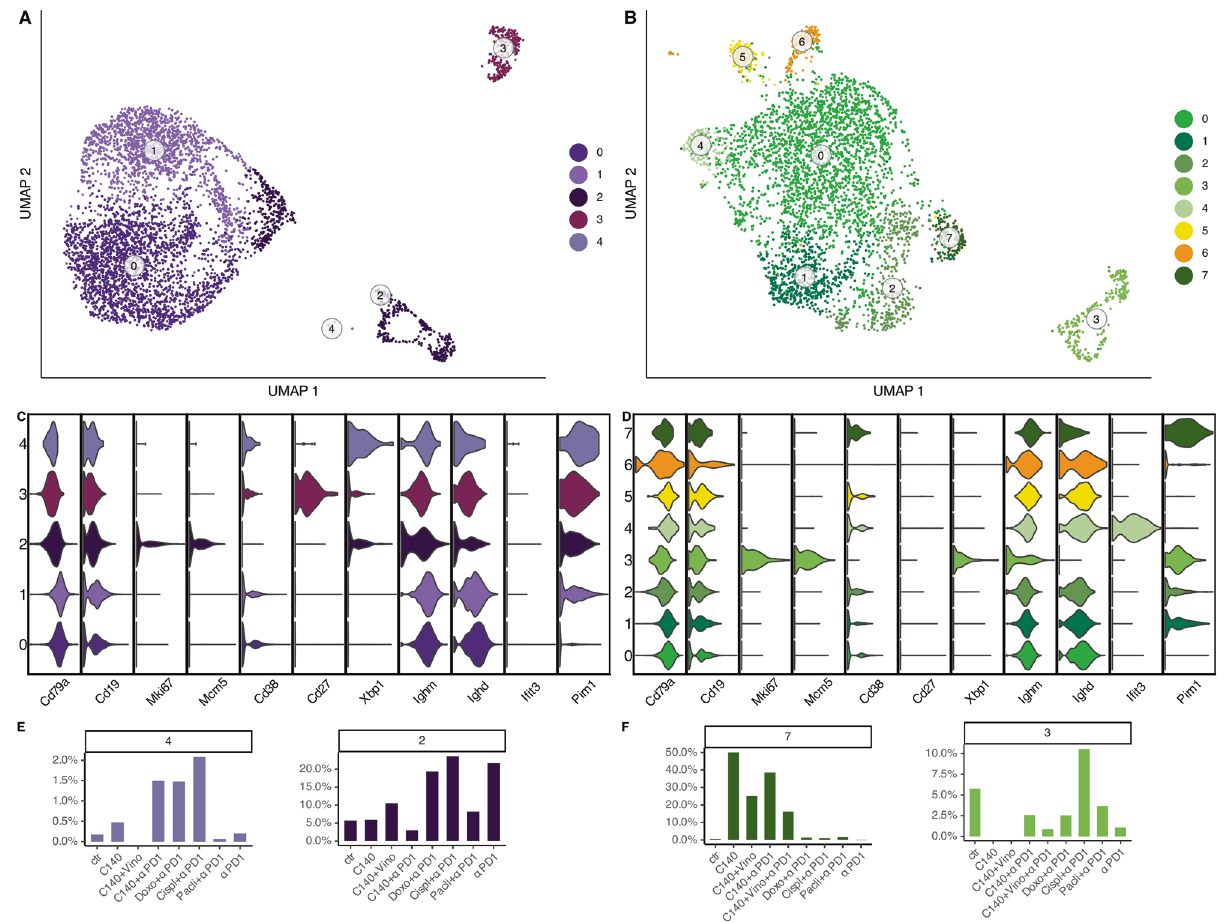
Fig. 5 B-like cell sub-clustering analysis in 4T1 and EMT6. UMAP of B cell sub-clustering in 4T1 A and EMT6 B . Gene signature of B cell sub- clustering in 4T1 C and EMT6 D . Proportions of cells in relevant 4T1 E and EMT6 F B cell sub-clusters among different